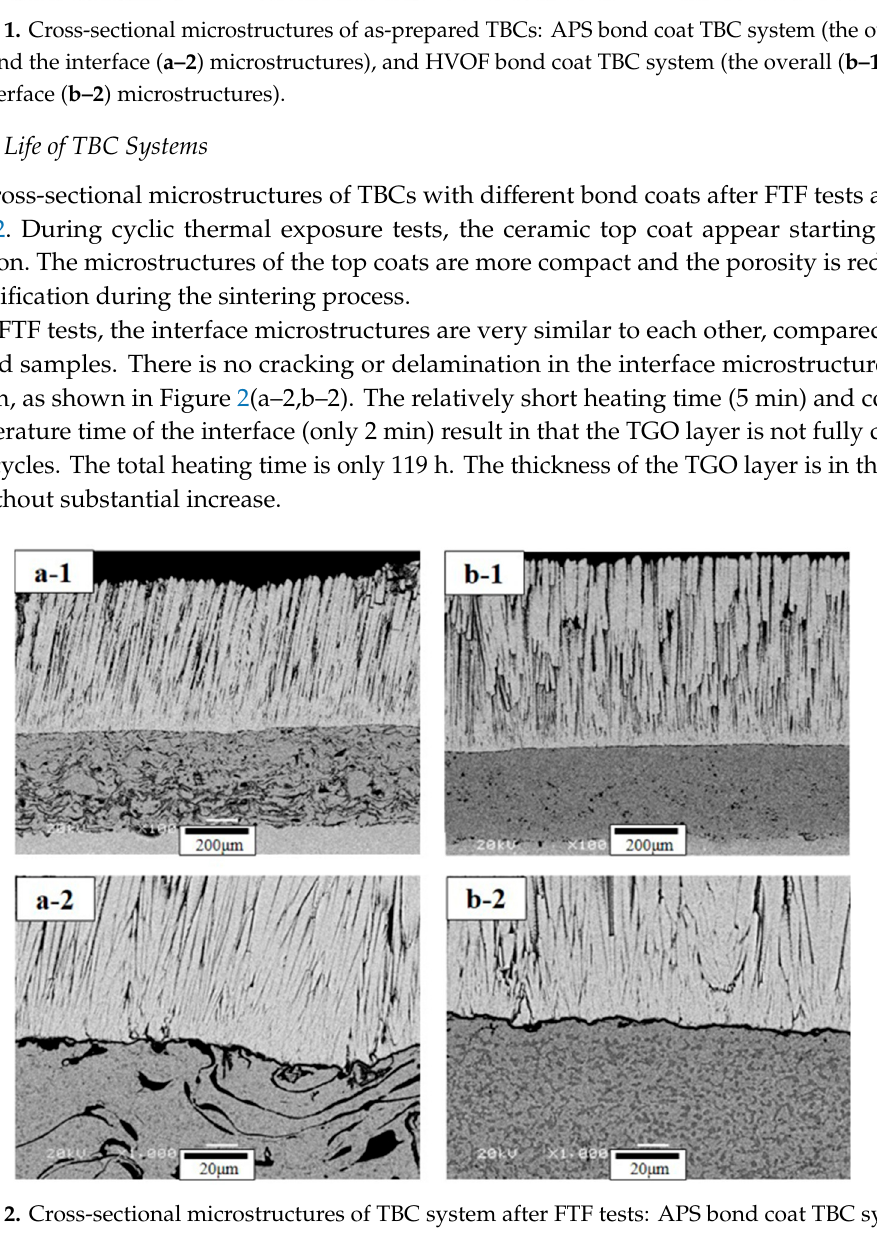
Figure 2. Cross-sectional microstructures of TBC system after FTF tests: APS bond coat TBC system (the overall ( a–1 ) and the interface ( a–2 ) microstructures) and HVOF bond coat TBC system (the overall ( b–1 ) and the interface ( b–2 ) microstructures).